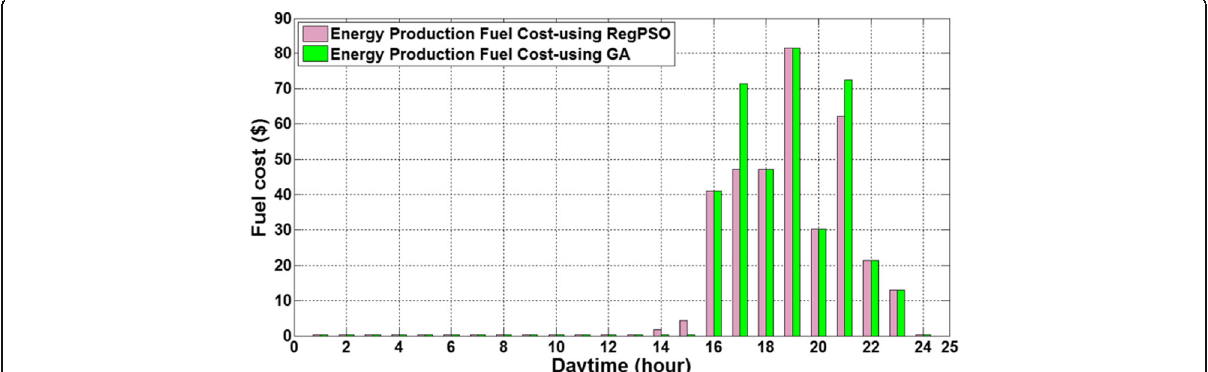
Fig. 16 Hourly comparison of energy production fuel costs in isolated mode of